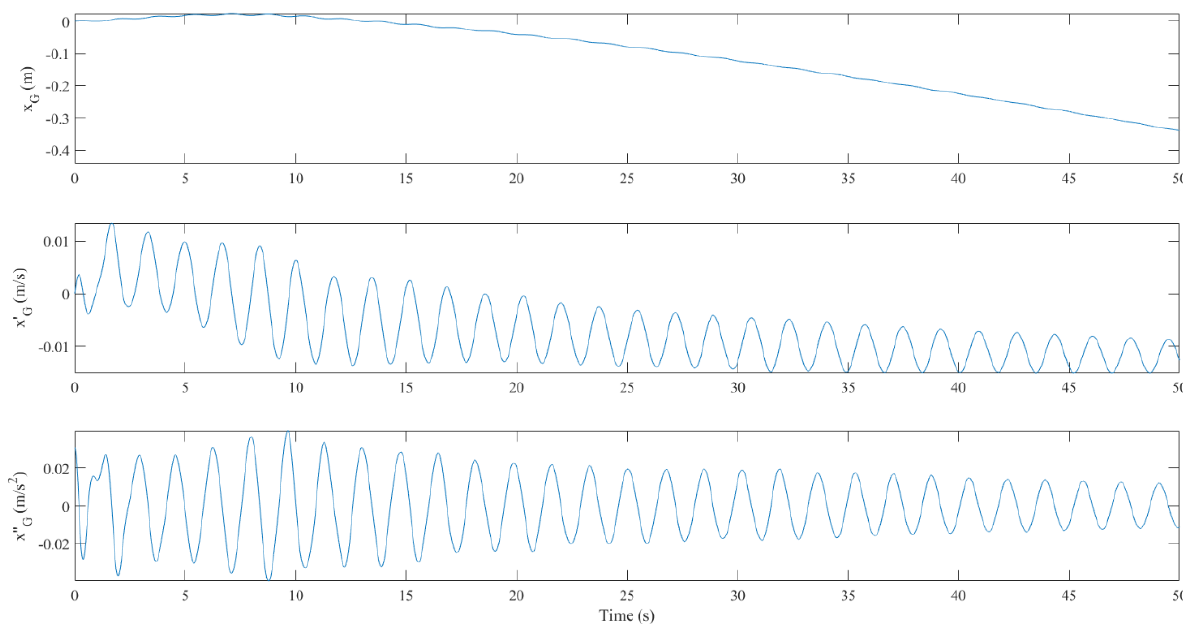
Figure 3. The horizontal displacement, velocity, and acceleration time histories of the floating body under free vibration at an initial 5° pitch.